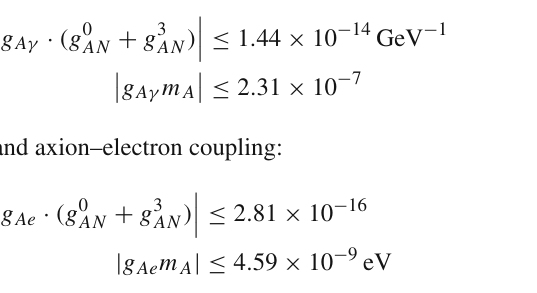
by a 8 . 18 g Tm 3 Al 5 O 12 crystal with a TES directly evapo- rated on the crystal surface. We have collected data for 3 . 86 days of effective measurement time with a 169 Tm exposure equal to 19 . 2 g · day. From the data acquired, we set compet- itive limits on the axion coupling constants to electrons and